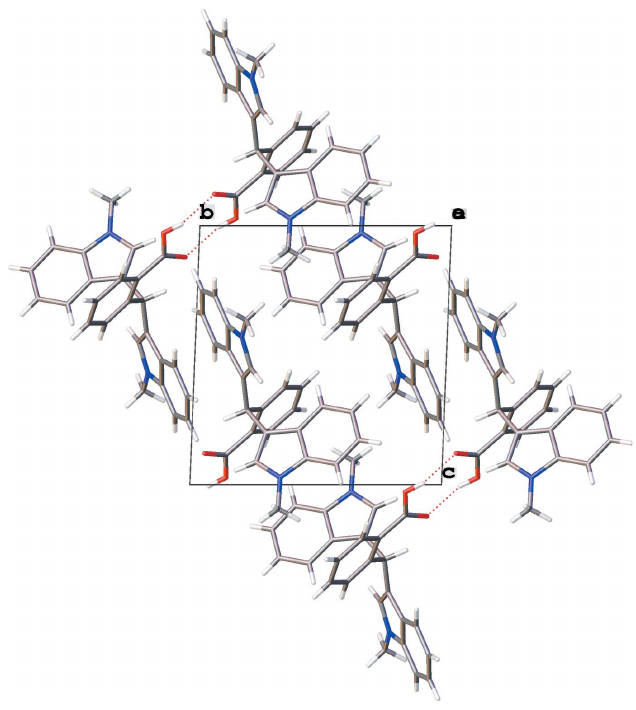
Figure 2 Crystal packing of the title compound viewed down [100] showing